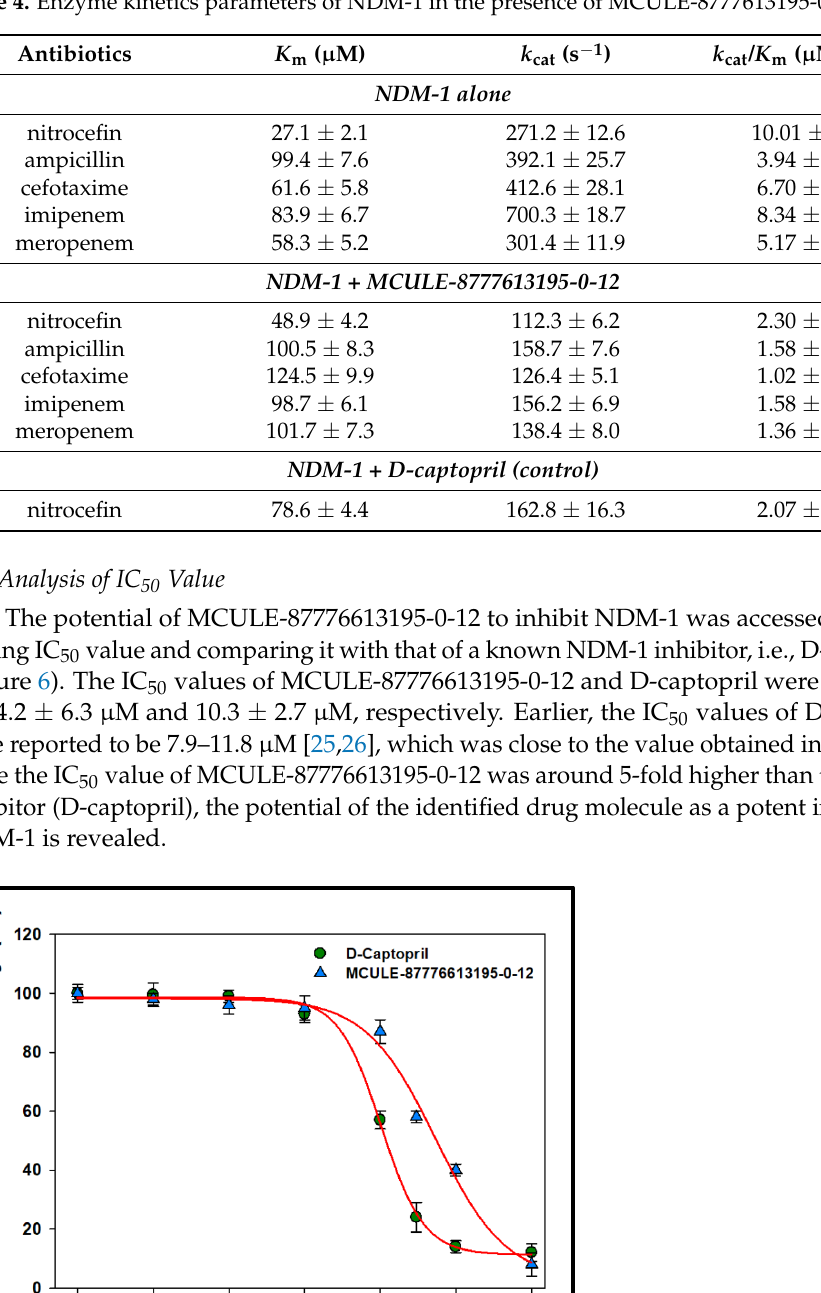
Table 4. Enzyme kinetics parameters of NDM-1 in the presence of MCULE-8777613195-0-12.